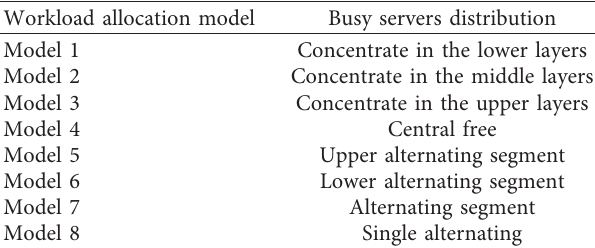
Table 2: Allocation modes of busy